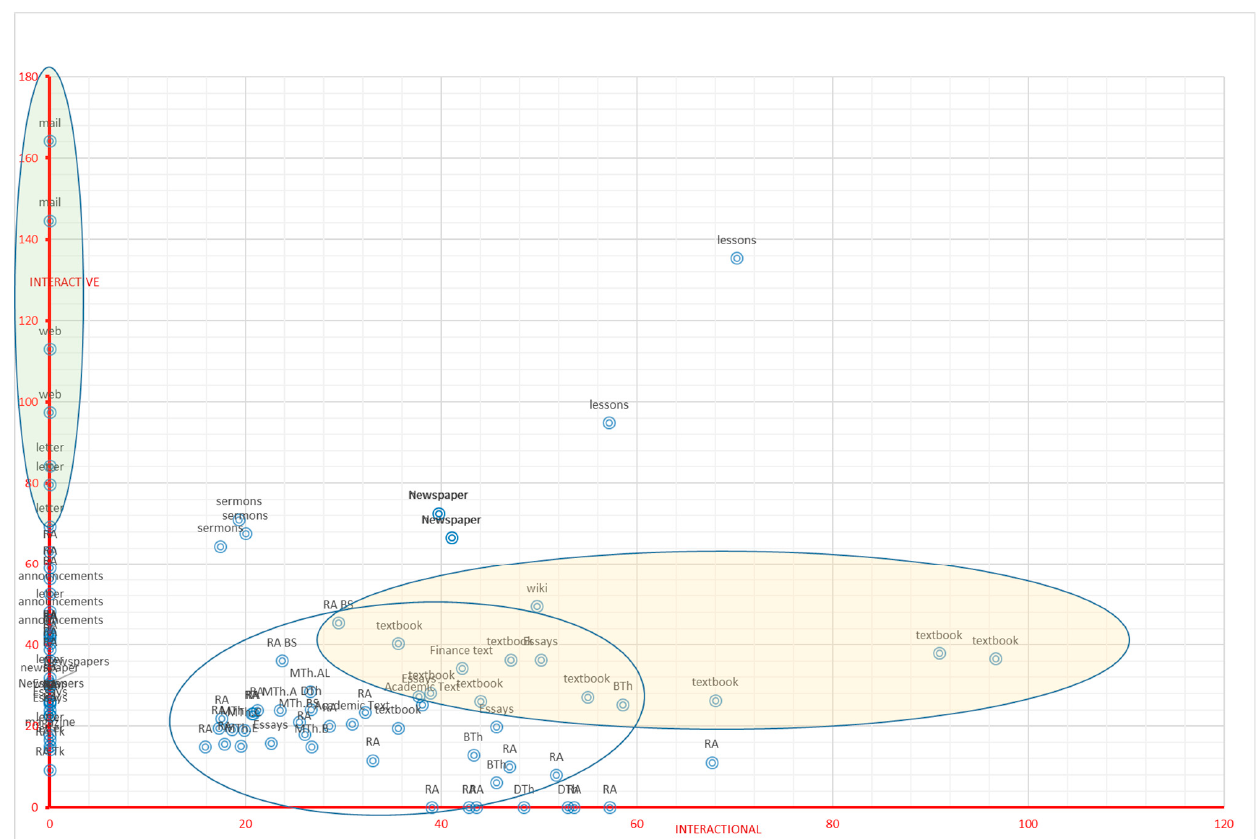
Figure 10. Distribution as a function of the presence of interactional vs. interactive markers.